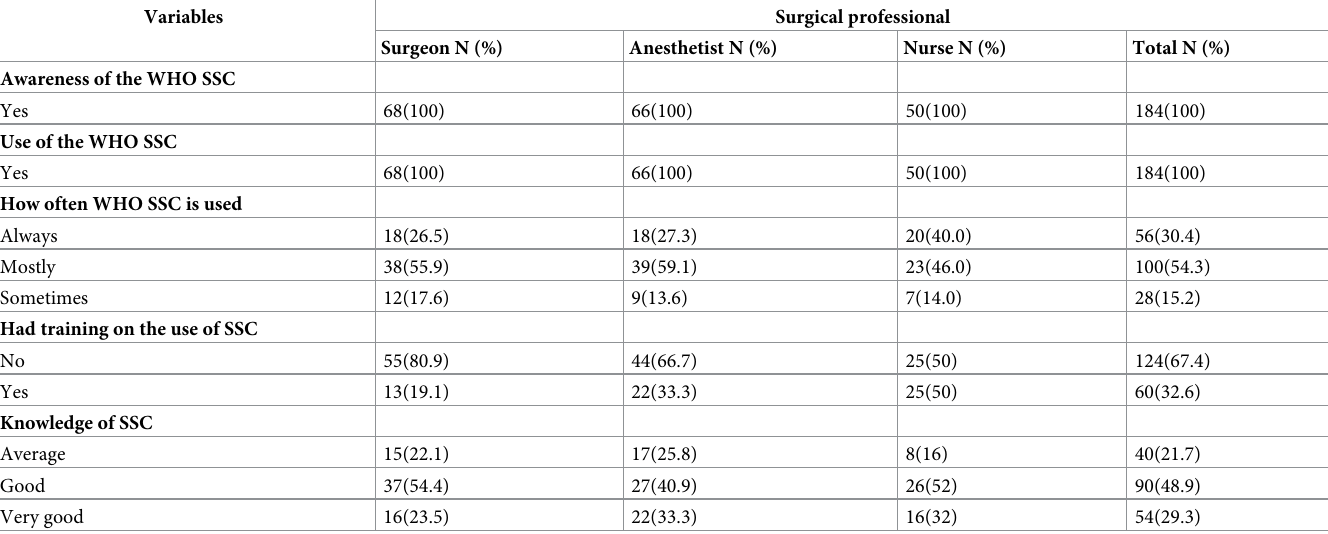
Table 2. Surgical provider reported utilization of the WHO